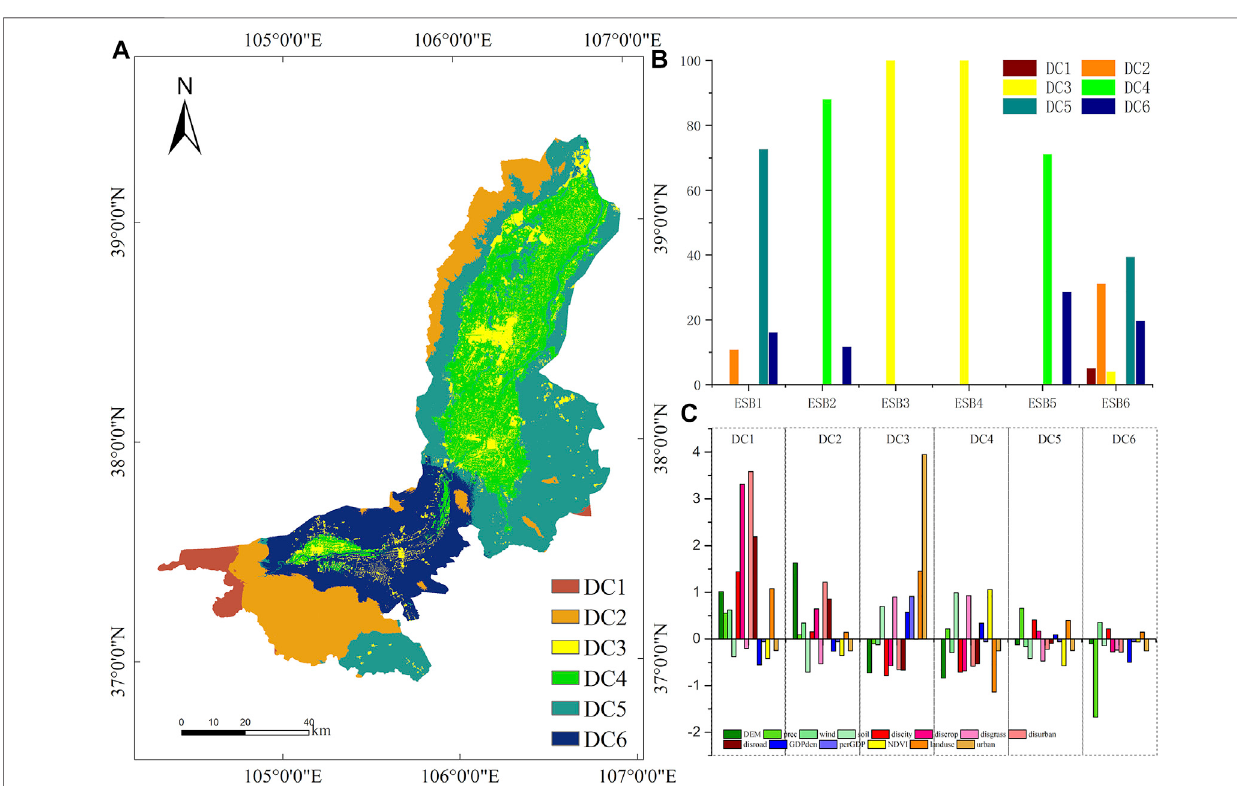
FIGURE 7 | Spatial distribution of driver clusters (A) , overlap percentage of driver clusters and ES bundles (B) , and z-score values of each driver in different clusters (C) .